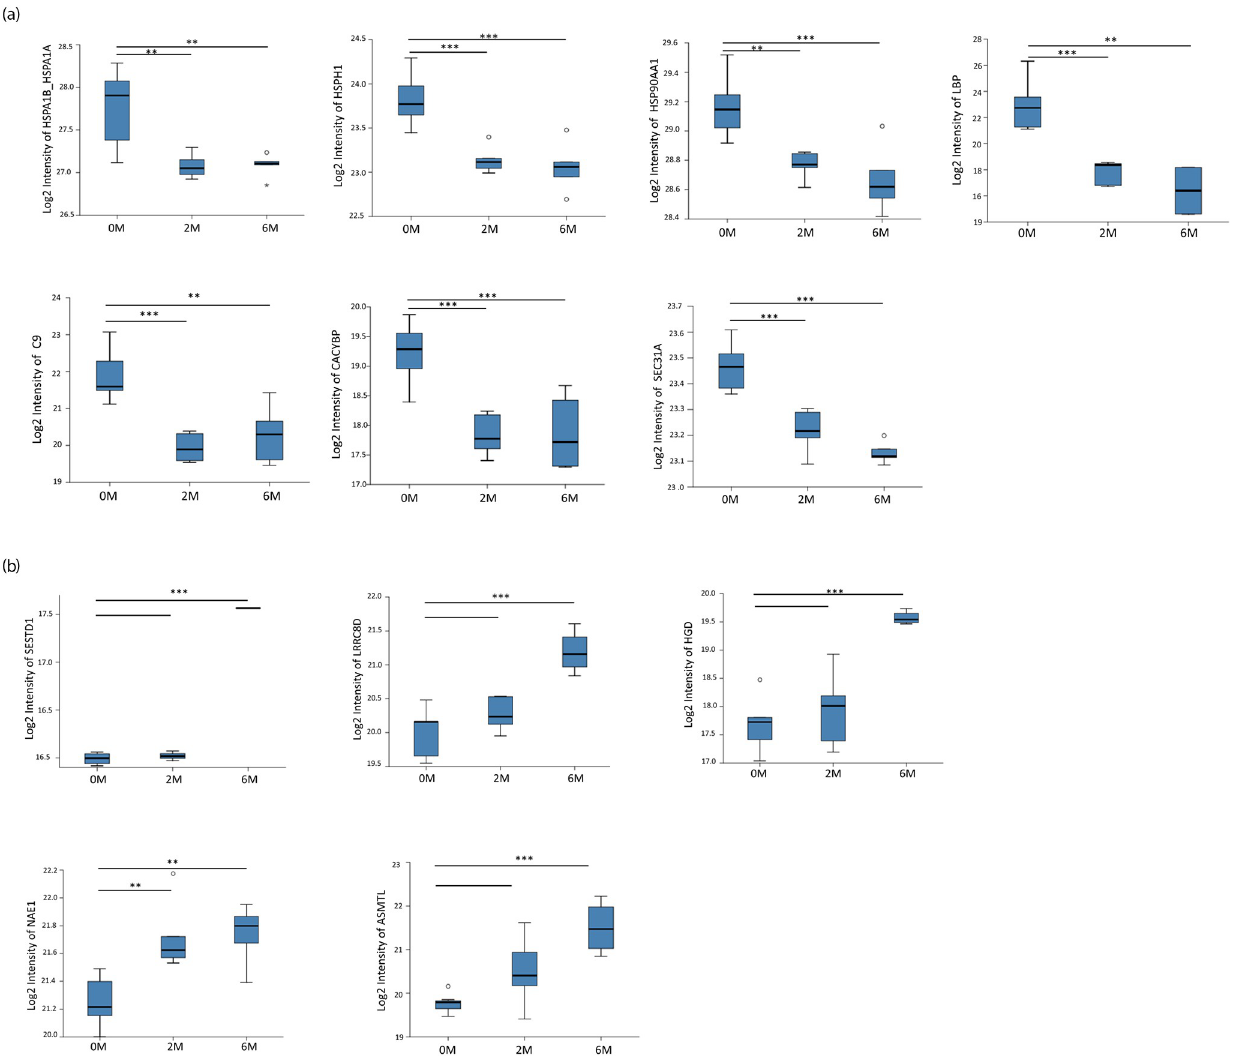
Fig 3. Box plots displaying the median, interquartile range, and the minimum and maximum values of Log2 intensity of the differentially expressed proteins identified among patients with pulmonary tuberculosis. (A) represents the downregulated proteins after 6 months of treatment. (B) represents the upregulated proteins. A p-value of less than 0.05 indicates statistical significance using ANOVA and Tukey’s range test. � p < 0.05; �� p < 0.01; ��� p < 0.001. The X-axis represents the time of treatment in months (0M, baseline; 2M, 2 months; 6M, 6 months of treatment). The Y-axis depicts the Log2 Intensity of each of the